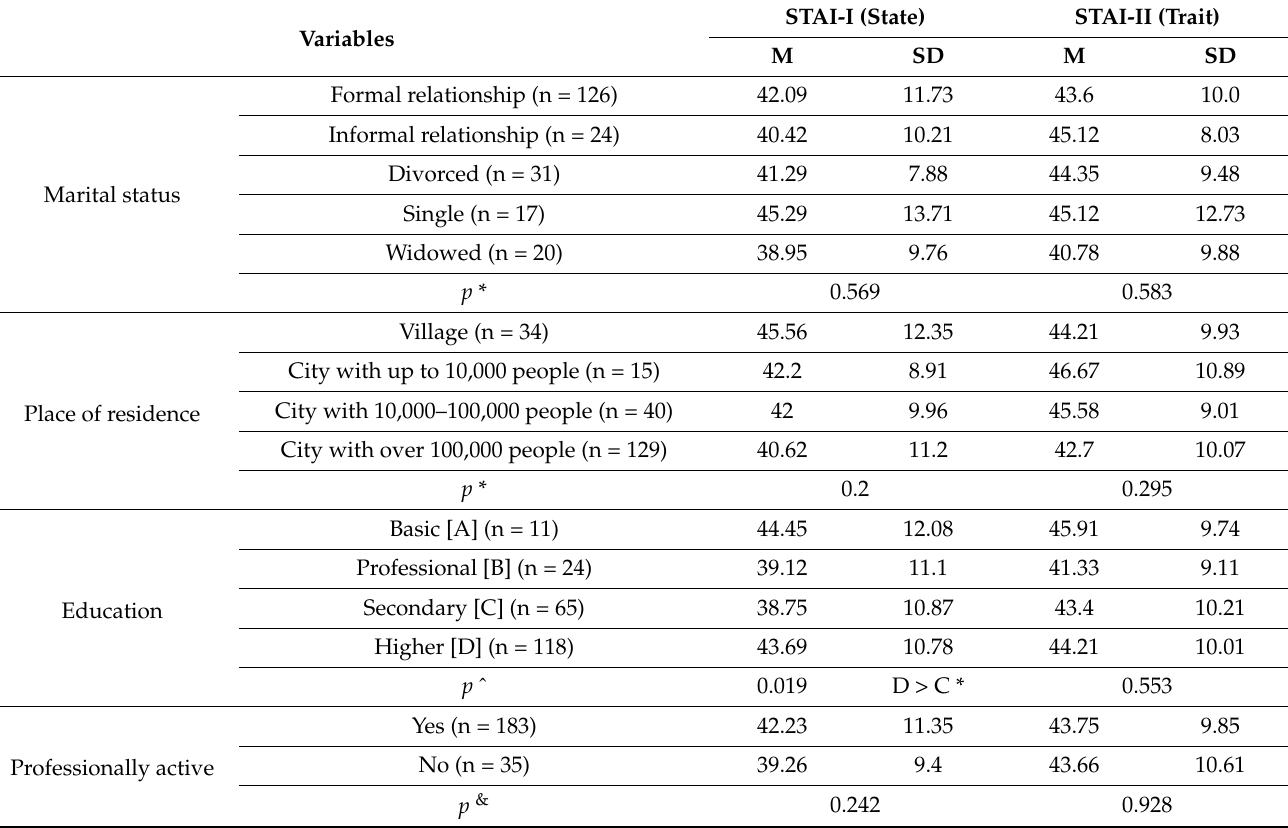
Table 2. Influence of age on the occurrence of depression according to the BDI, anxiety according to the STAI, climacteric symptoms according to the BKMI and social support according to the ISSB. Age Variables r p BDI − 0.095 0.164 STAI-I (state) − 0.142 0.036 STAI STAI-II (trait) − 0.107 0.115 BKMI 0.069 >0.05 emotional support 0.021 0.759 information support 0.086 0.206 ISSB